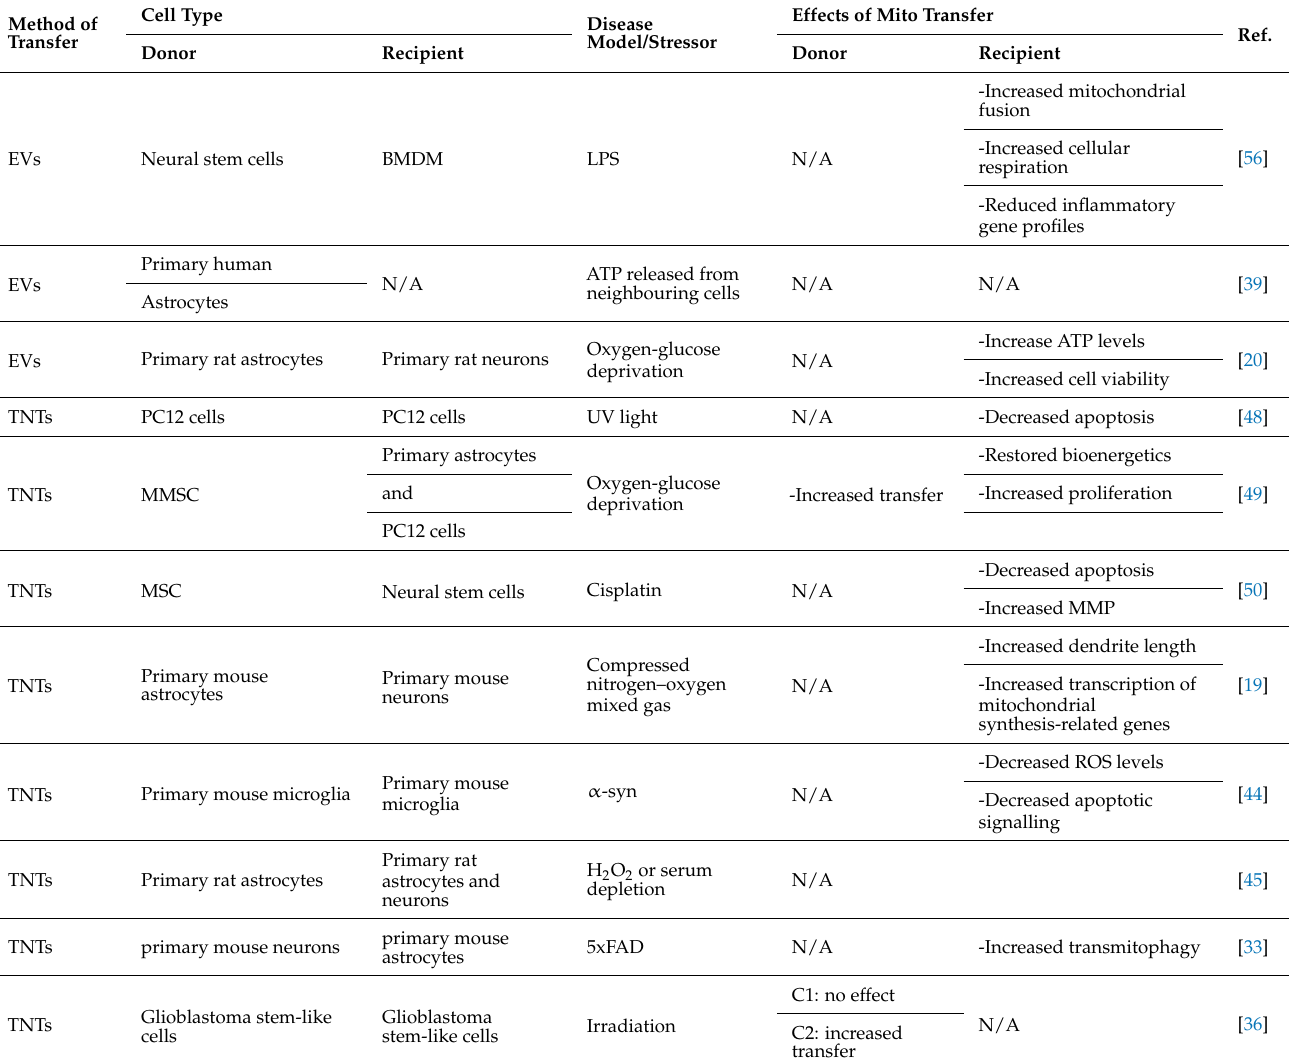
Table 1. Mechanisms of Mitochondria Transfer in the